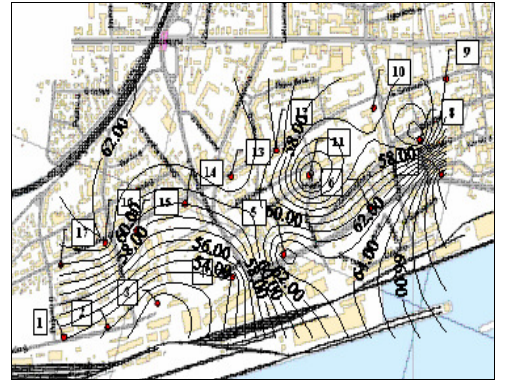
Fig. 5. Noise spread in the northern part of Klaipėda city in the daytime in